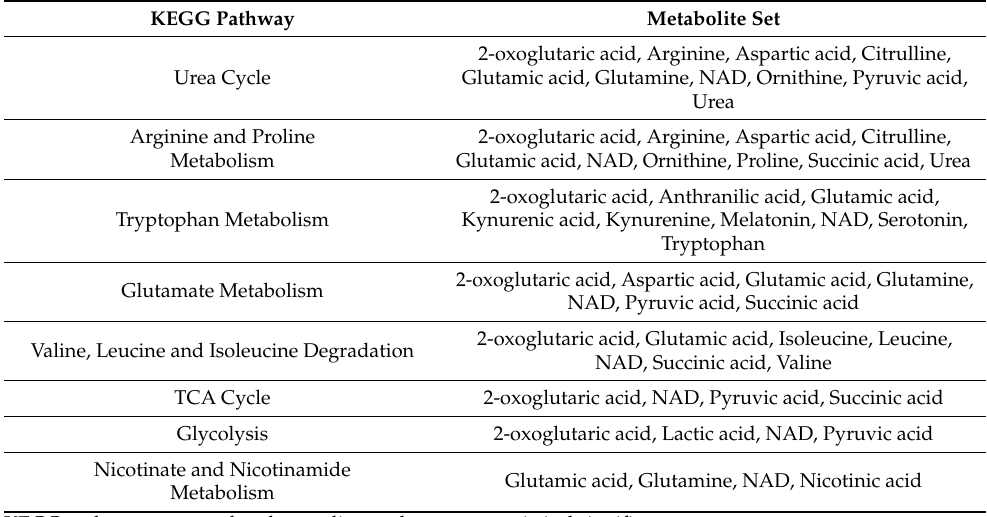
Figure 3. The common metabolites and metabolic pathways obtained from the review of plasma and serum metabolomics studies are summarized. A specific signature of the metabolome of COVID ‐ 19 patients was obtained representing the most enriched pathways constructed through an over ‐ representation analysis (ORA) within MetaboAnalyst 5.0 and represented as bubble plot. The bubble plot takes into account the statistical significance (–log p ‐ value) of each metabolite set identified through the ORA analysis. Where the size of each bubble refers to the number of times the metabolite set is cited in this review by each author, the color instead refers to the number of metabolites detected over the total number of metabolites within that pathway (occupancy). On the right, the metabolites common to all the reviewed papers that have generated the pathway enrichment are grouped. Table 5. Details of the metabolite sets enriching the KEGG pathways that constitute the metabolic signature of